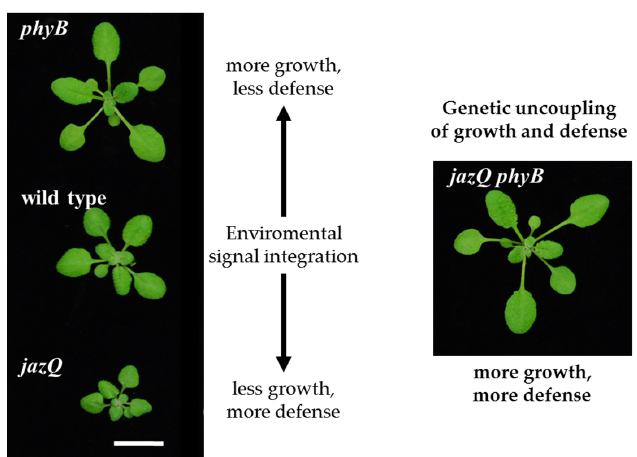
Figure 1. Genetic uncoupling of growth and defense in Arabidopsis. The jazQ phyB mutant combines the large rosette of phyB with elevated defenses of jazQ . Photograph of 3 weeks old wild type, jazQ phyB , phyB and jazQ rosettes. Plants were grown in soil and maintained at 20 °C (±1 °C) under 16 h at a light intensity of 120 µ mol m − 2 · s − 1 and 8 h dark. Bar = 1